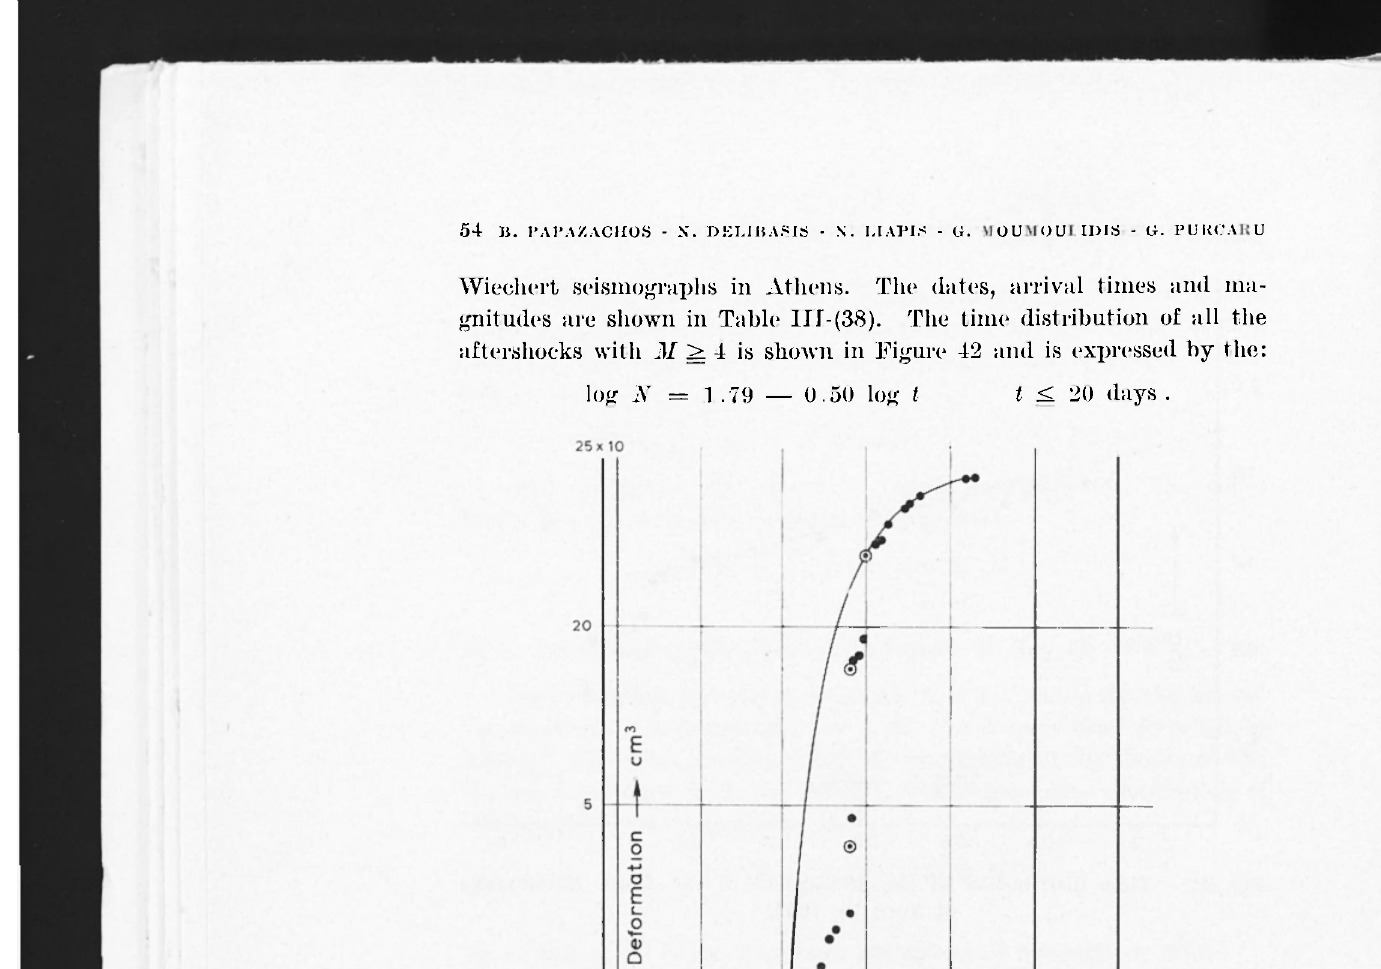
Fig. 44 - Deformation characteristics of the aftershocks of the Zante Earthquake of April 10, 1ÜC2. The cumulative frequency of the magnitude of the aftershocks, is shown in Figure 43 and is expressed by the: log N = 5.88 — 1.07 M